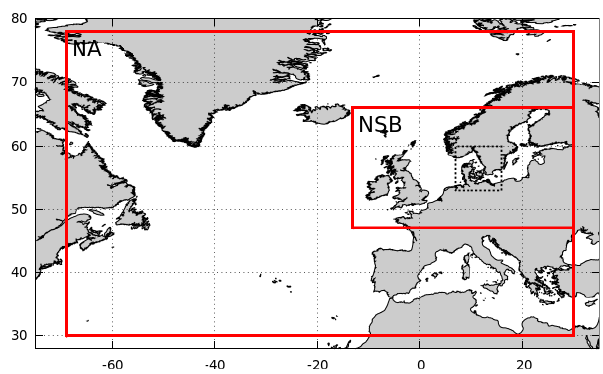
Figure 1. Nesting of domains in DMI-WAM. The outer frame is the North Atlantic (NA) domain, and the inner frame is the North Sea/Baltic Sea (NSB) domain. The dotted frame is the transition area. Only data from the NSB domain are analyzed in this